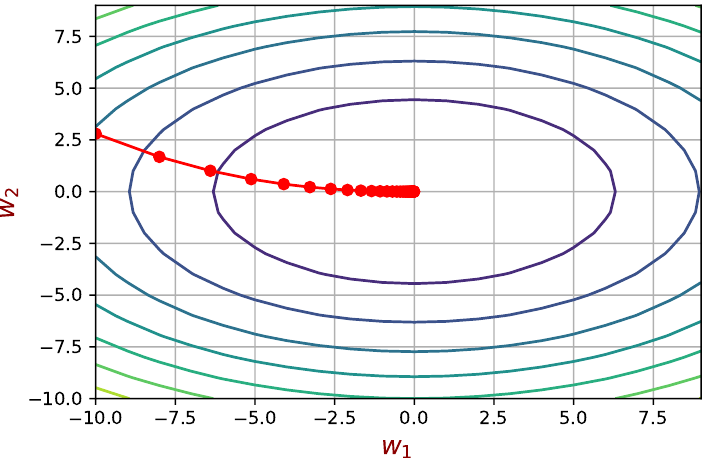
Figure A3. The red line displays the path taken by the gradient descent in the f domain to find its minimum. The ellipses correspond to the level curves of f